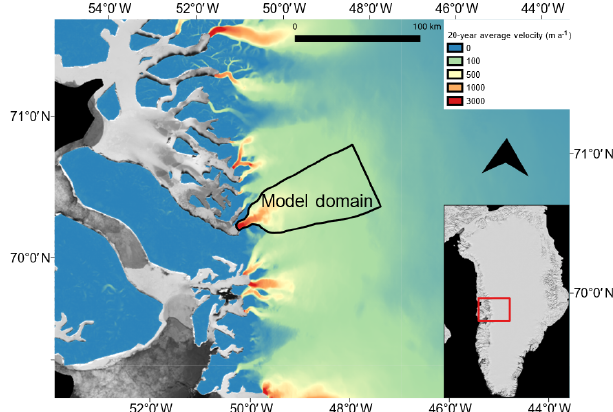
Figure 1. Location of Store (inset) and model domain. Background shows the 20-year velocity average from the MEaSUREs dataset (Joughin et al., 2016,